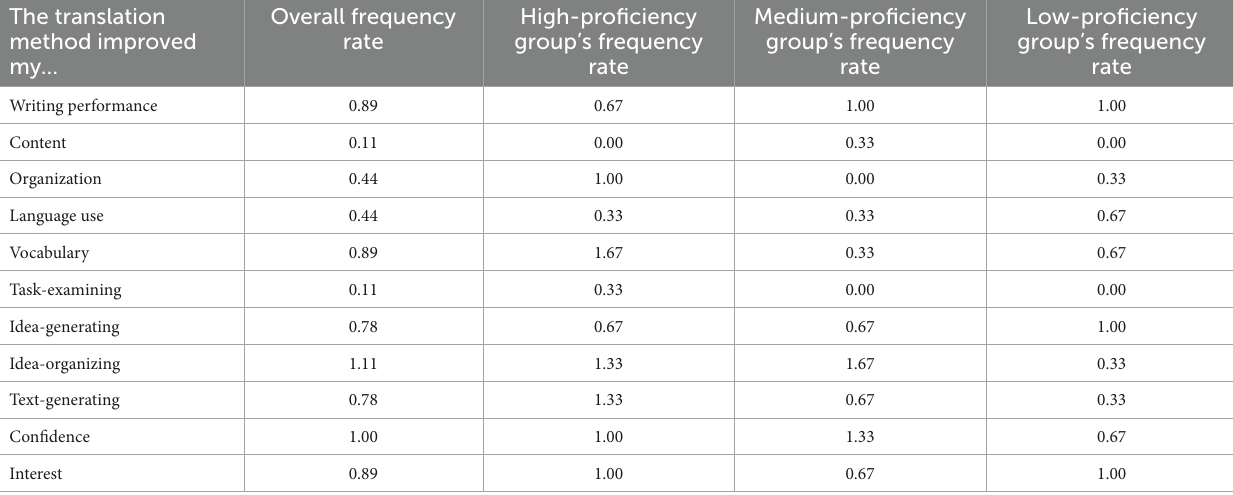
TABLE 5 Frequency rate of the effect of translation methods as indicted in the qualitative data